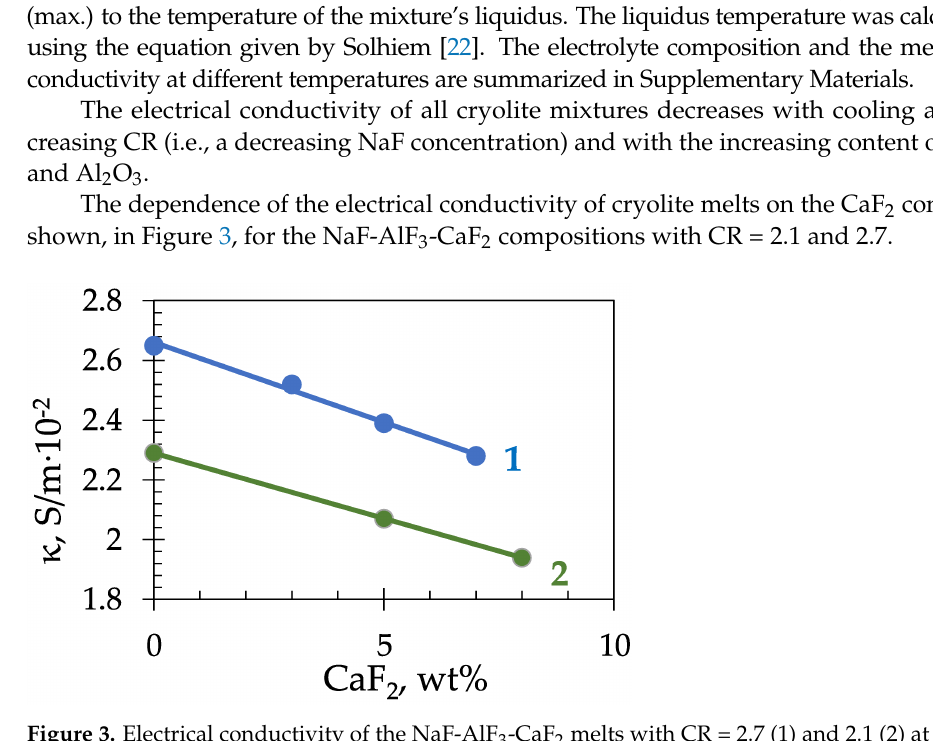
Figure 3. Electrical conductivity of the NaF-AlF 3 -CaF 2 melts with CR = 2.7 (1) and 2.1 (2) at 1273